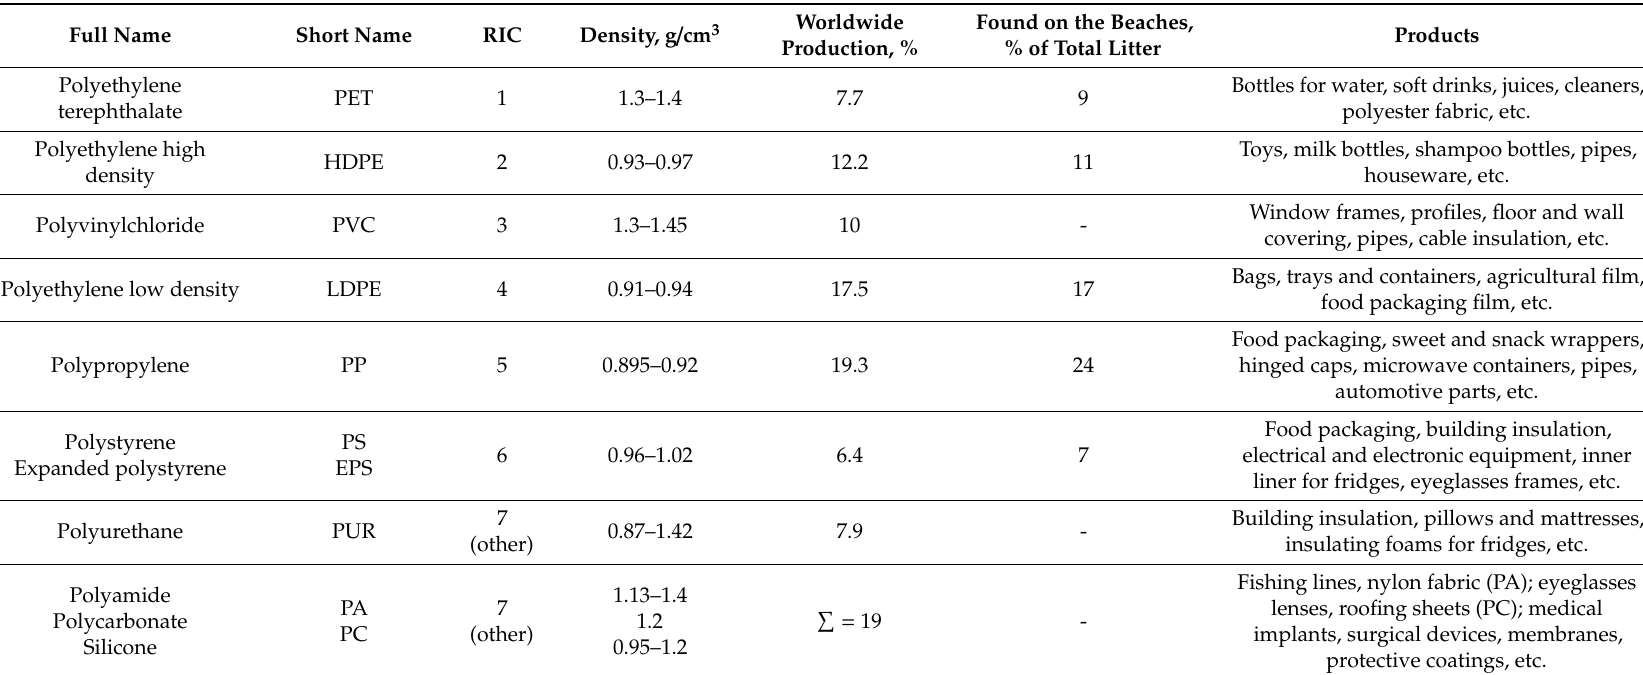
Table 1. Worldwide production of di ff erent polymer types and their discovery on